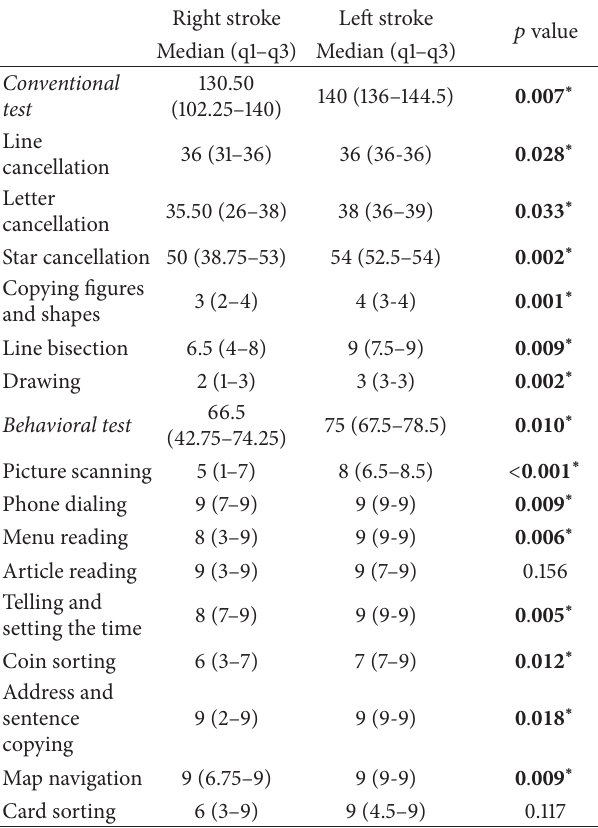
Table 6: Comparison of groups according right or left damaged side ( 𝑛 = 75